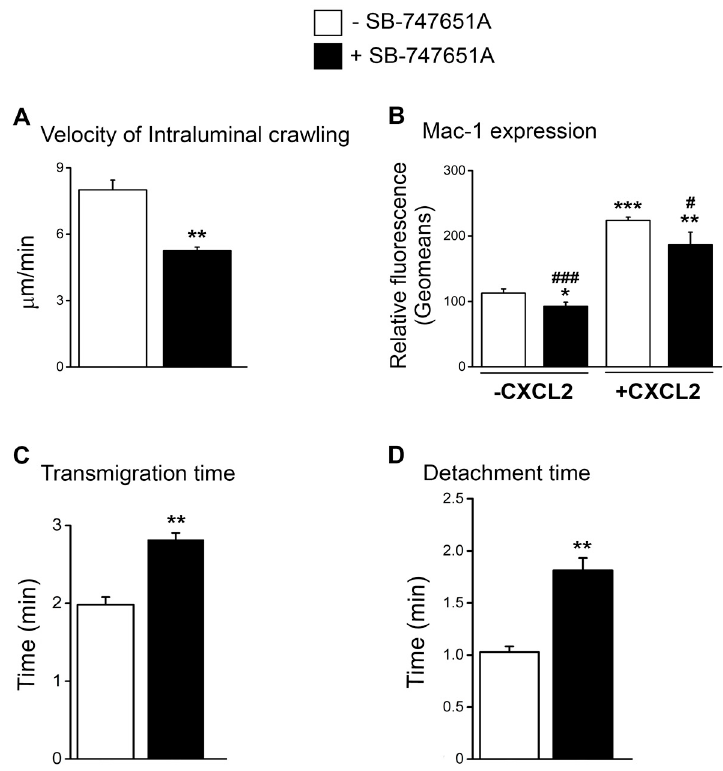
Figure 3. Effect of SB-747651A on CXCL2-induced Mac-1-dependent intraluminal crawling and transendothelial migration. ( A ) The velocity of intraluminal crawling ( µ m/min) of neutrophils crawling in the luminal surface of the endothelium upon stimulation with CXCL2 in the absence (Control, white bar) or in the presence (black bar) of MSK1 inhibitor SB-747651A (5 µ M) 30 min prior to and 60 min following the placement of CXCL2-containing gel. Data are means ± SEM ( n = 4). ** indicates significant difference ( p < 0.01) from the Control. ( B ) Means ± SEM ( n = 3) of Mac-1-dependent fluorescence expressed as geomeans in untreated neutrophils (Control; white bar) and in neutrophils treated with SB-747651A (5 µ M, 30 min prior to addition of CXCL2; black bar) in the absence ( left bars) or in the presence ( right bars) of stimulation with CXCL2 (30 nM for 10 min). *, **, and *** indicate significant difference ( p < 0.05, p < 0.01, and p < 0.001, respectively) from the Control without CXCL2. # and ### indicate significant difference ( p < 0.05 and p < 0.001, respectively) from the group without SB-747651A. ( C ) The duration (min) of neutrophil transmigration across the endothelium and ( D ) the detachment time (min) of neutrophils from the venule upon stimulation with CXCL2 in the absence (Control, white bar) or in the presence (black bar) of MSK1 inhibitor SB-747651A (5 µ M) 30 min prior to and 60 min following the placement of CXCL2-containing gel. Data are means ± SEM ( n = 4). ** indicates significant difference ( p < 0.01) from the Control.